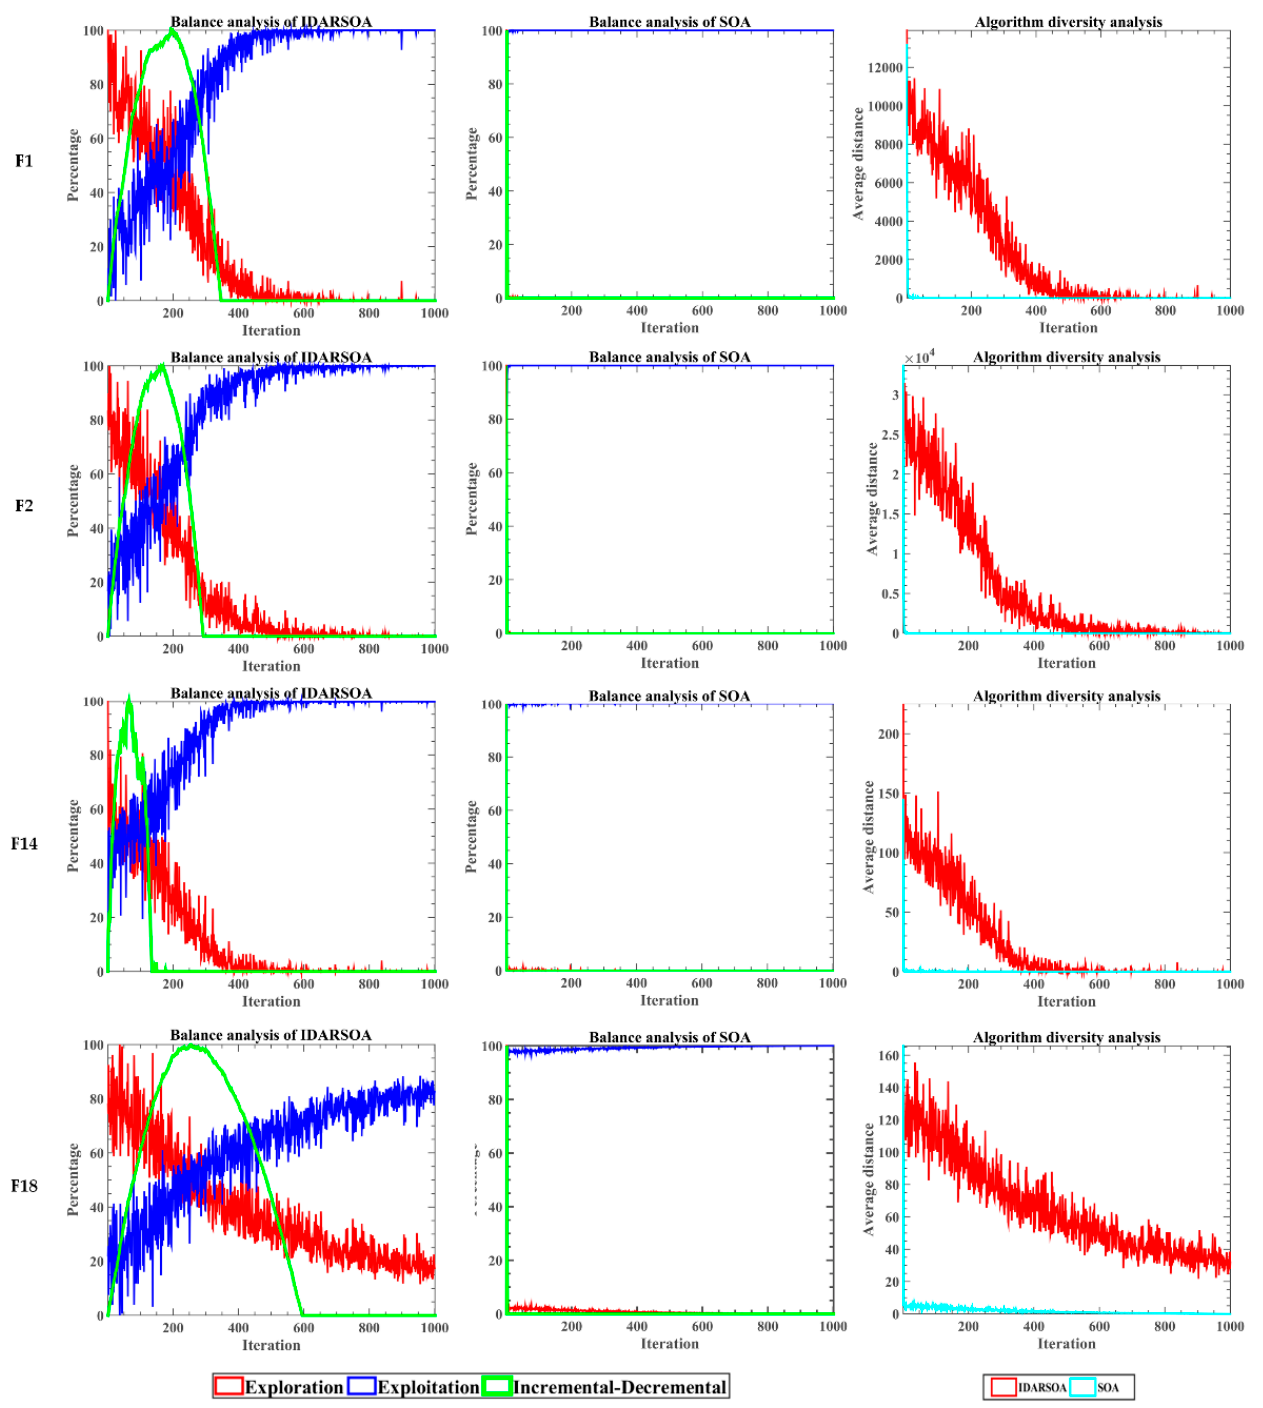
Figure 4. Balance and diversity analysis diagram of IDARSOA and SOA.